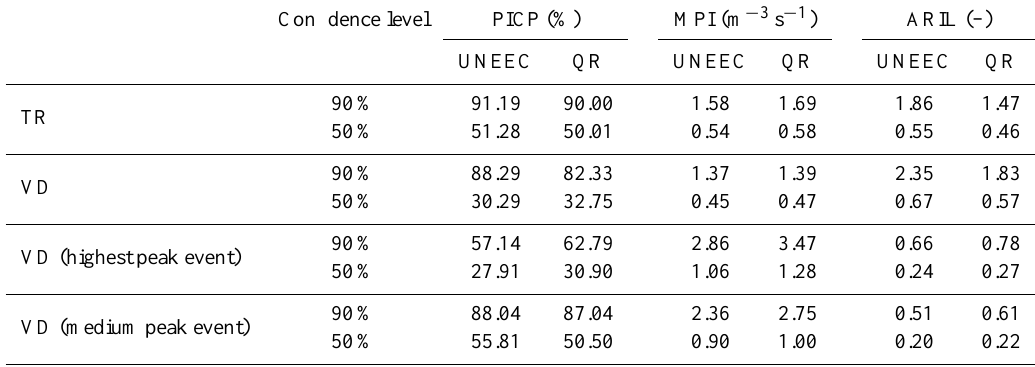
Table 2. Uncertainty analysis results for 90 and 50% confidence levels (Brue catchment).